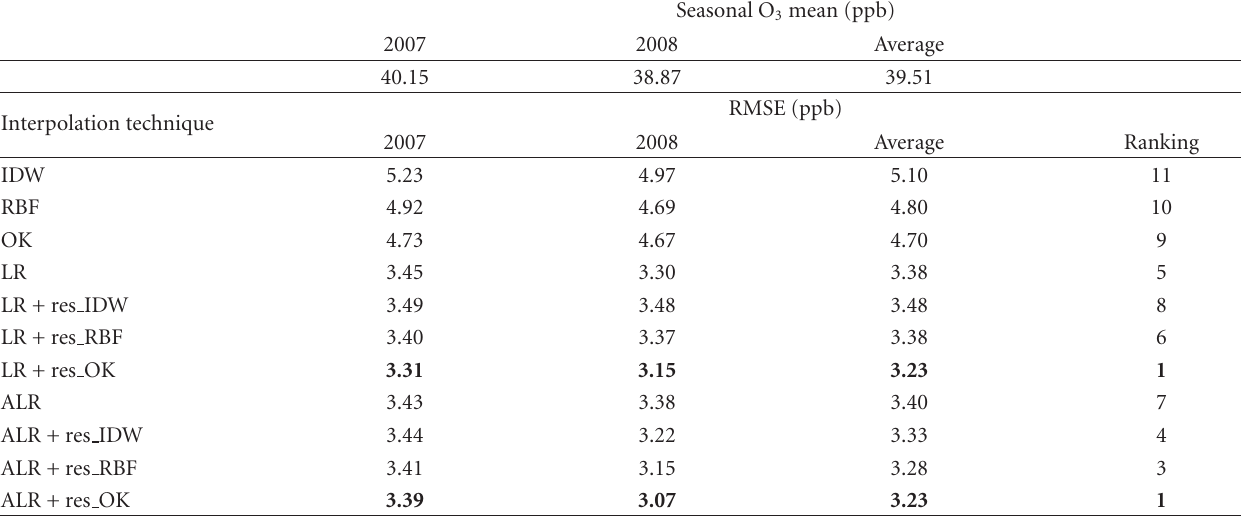
Table 2: RMSE values (ppb) from cross-validation: comparison for di ff erent interpolation techniques for O 3 means, 2007-2008 vegetation seasons.